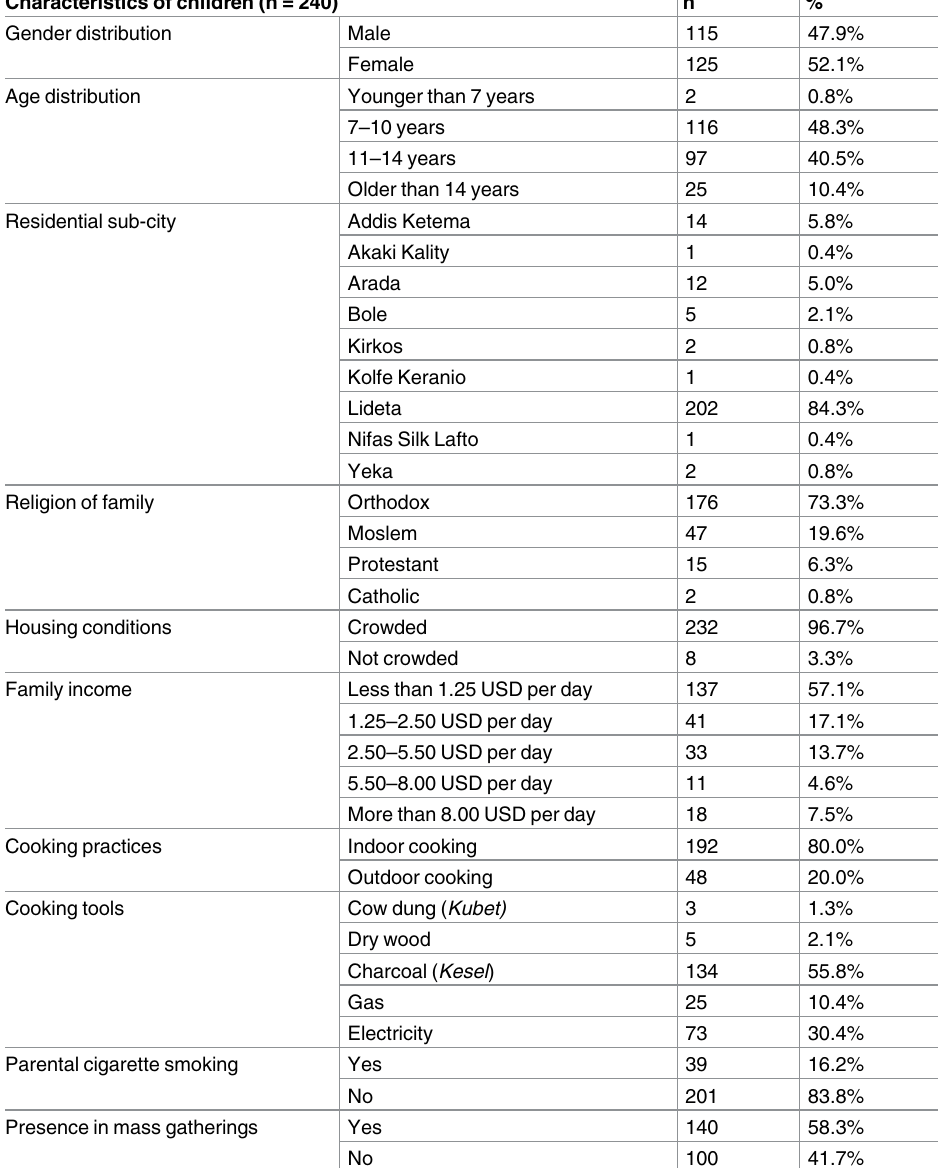
Table 1. Socio-demographic and clinical characteristics of all